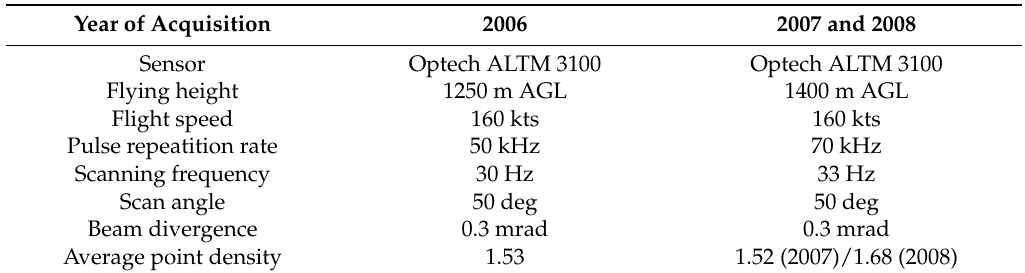
Table 3. Airborne laser scanning (ALS) data acquisition